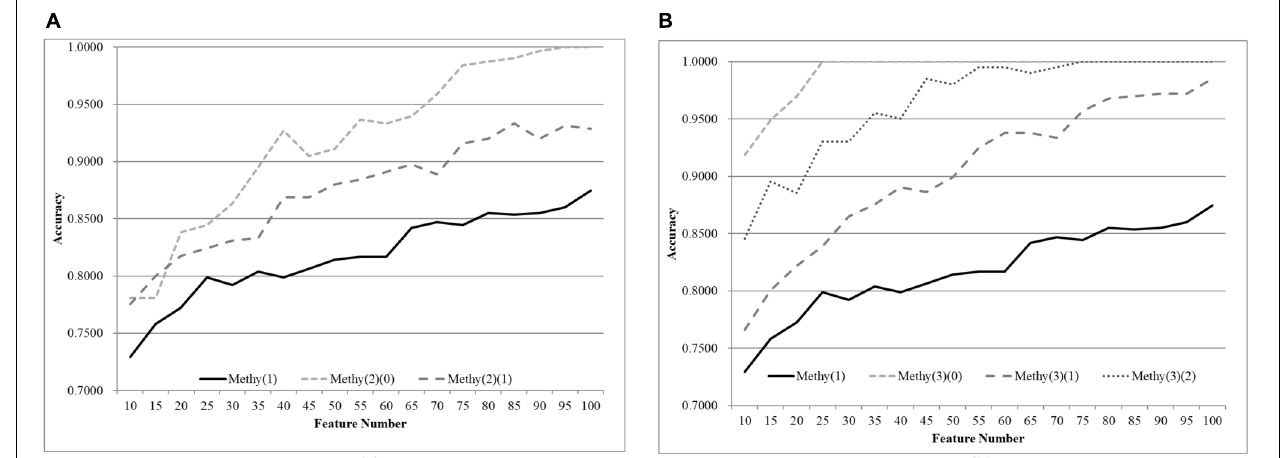
FIGURE 4 | Comparison of early-stage breast cancer detection models with different age groups based on methylome data. The patients were split into (A) two groups and (B) three groups with equally-sized age ranges. The horizontal axis depicts the numbers of features chosen by rfeSVM and the vertical axis depicts the 10-fold cross-validation accuracy of the classifier SVM. F -test was used to generate the initial subset of the 1000 top-ranked features.